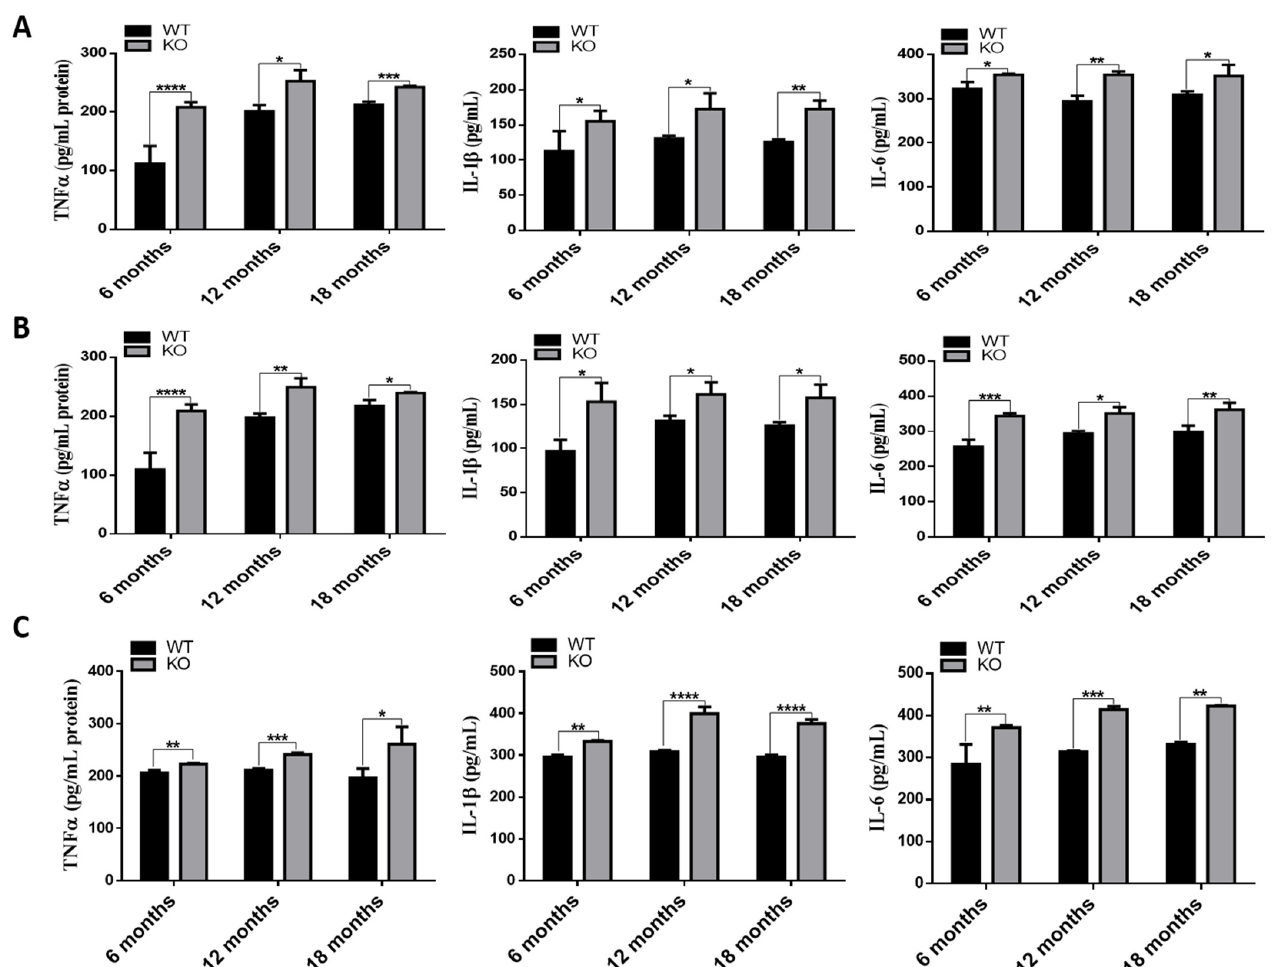
Figure 6. The levels of the inflammatory cytokines: TNF α , IL-1 β and IL-6, in RPE/choroid/sclera ( A ), retina ( B ) and brain ( C ) of WT and Tspo KO mice at the ages of 6, 12 and 18 months. The data were presented as means ± SD and analyzed by two-way ANOVA with the appropriate post hoc test Bonferroni multiple comparisons tests ( n = 5). * p < 0.05, ** p < 0.01, *** p < 0.001, **** p < 0.0001.